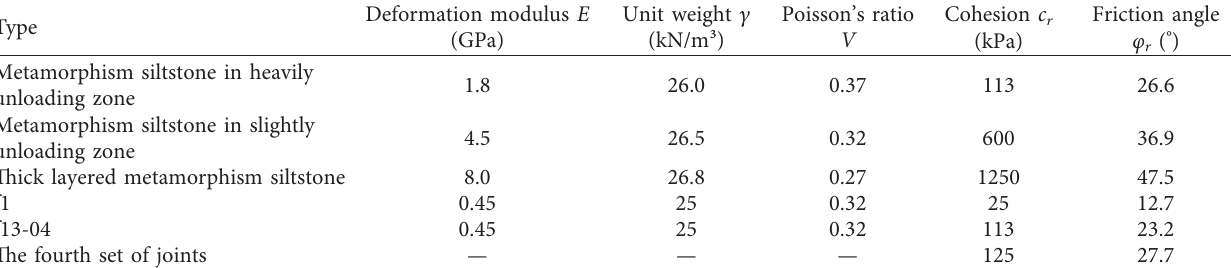
Table 2: Geotechnical parameters for strength reduction procedure.